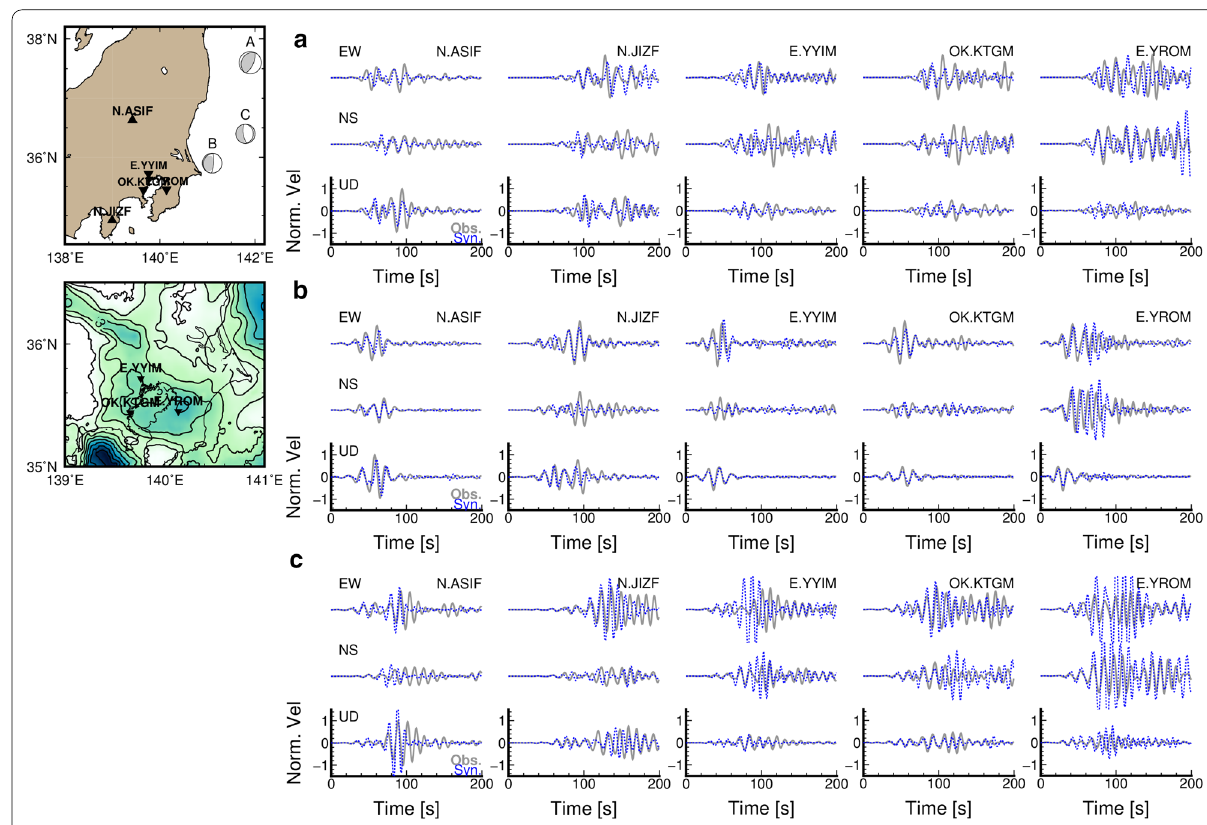
Fig. 11 Comparisons between observed and simulated seismograms for periods of 10–20 s. We selected two F-net (N.ASIF and N.JIZF) and three MeSO-net (E.YYIM, OK.KTGM, and E.YROM) stations. Amplitudes at each station were normalized by the maximum amplitudes of observed seismograms for periods of 10-20 s at each station. a Event A, b Event B, and c Event C. Gray and blue dotted lines are the observed and simulated seismograms, respectively. Left panels show used stations and bedrock depths of the JIVSM. Color for bedrock depths is similar as Fig.